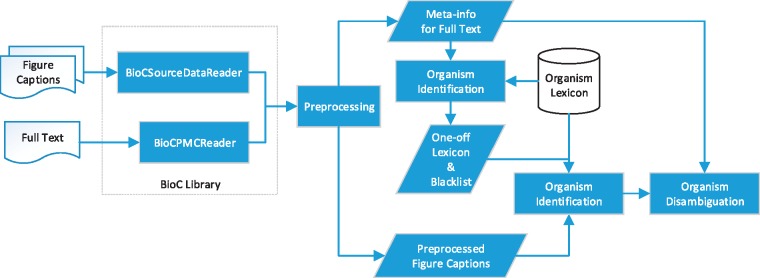
Workflow of SPRENO.